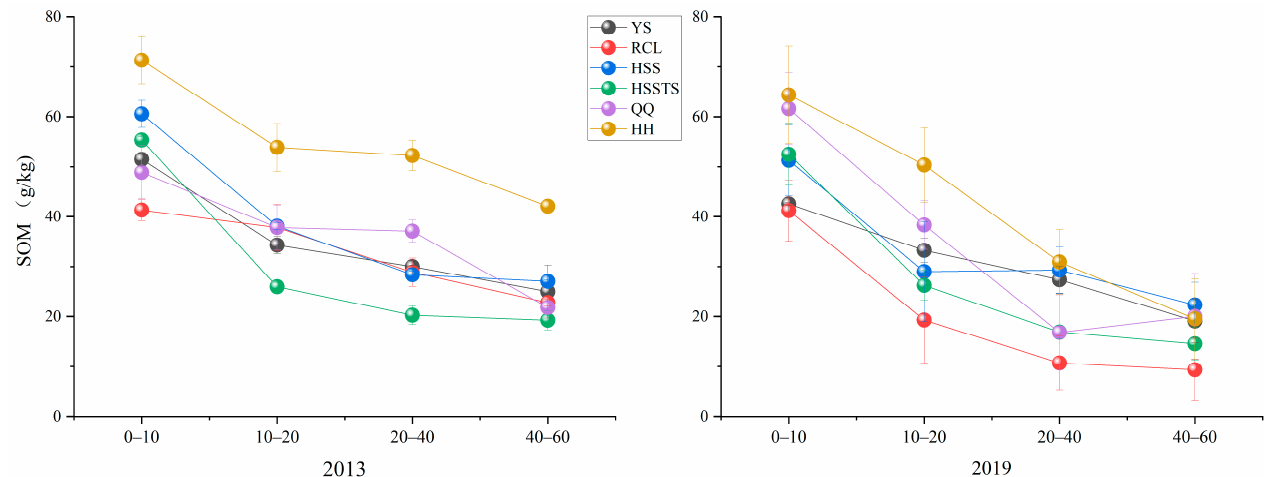
Figure 7. Soil organic matter (SOM) content of different forest communities at four soil depths in both 2013 and 2019.